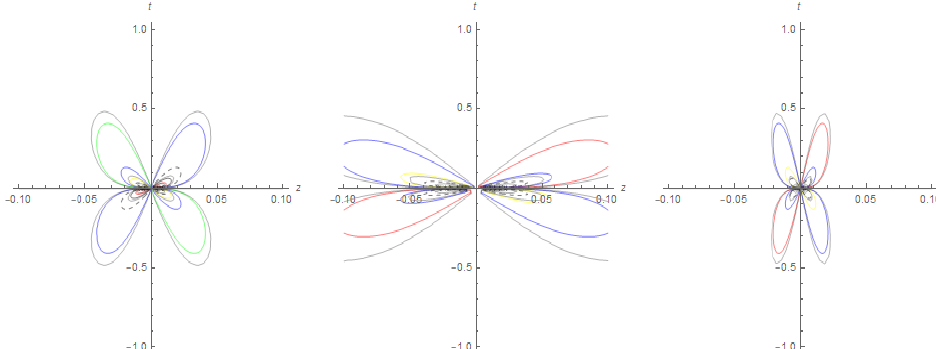
Figure 12. Contour graphs for Figure 11.